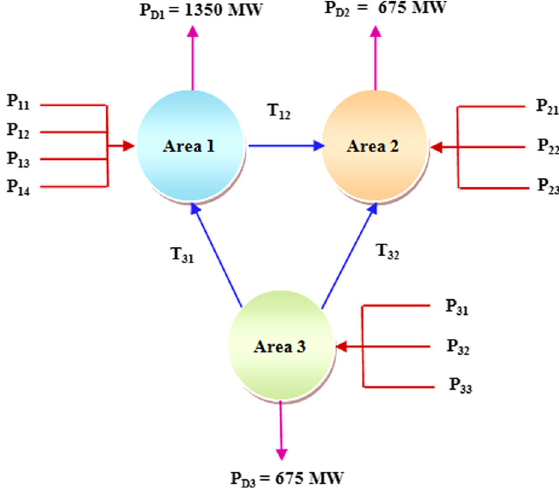
Fig. 7 Schematic diagram of the three-area